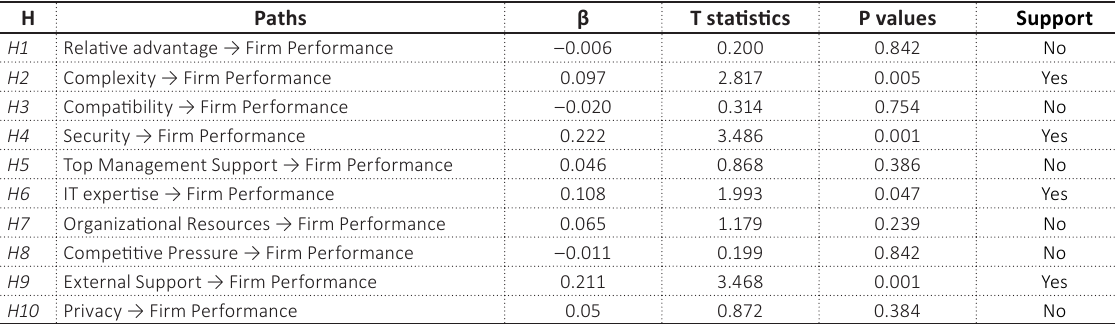
Table 2. Path coefficient of